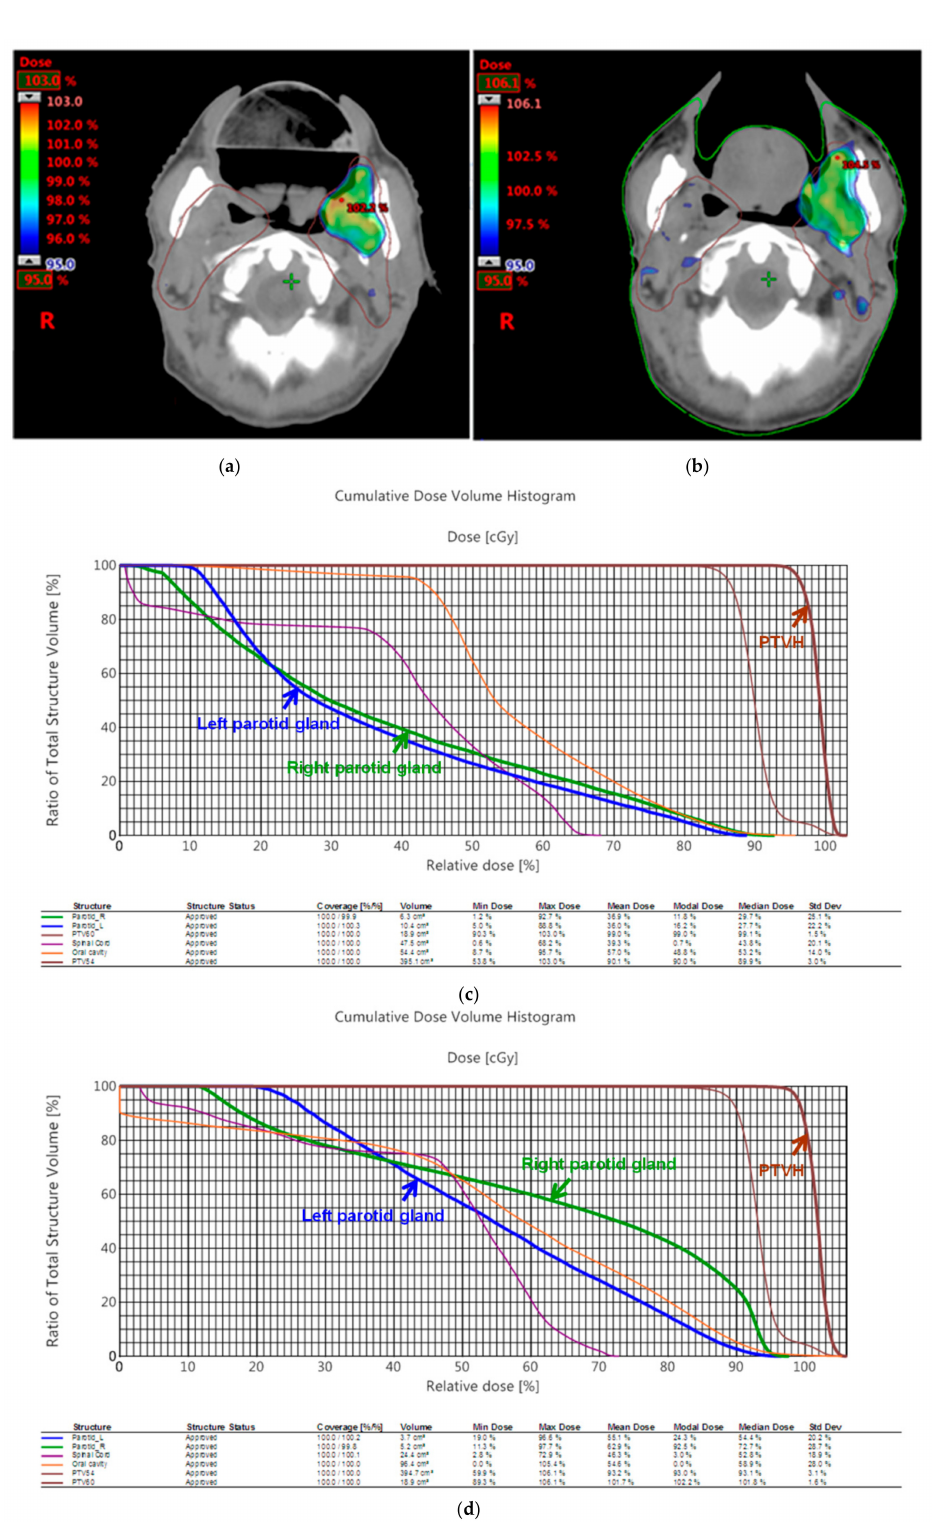
Figure 5. Dose distributions of Patient 2 with two plans with silicone 3D printed bite blocks or conventional oral corks. ( a ) Dosimetry with the silicone 3D printing bite block showed similar distribution in PTVH to that ( b ) containing the conventional oral cork. ( c ) In the DVH analysis, the RT dose that scattered to adjacent normal tissues such as bilateral parotid glands was lower when using the silicone 3D printing bite block than ( d ) with conventional oral